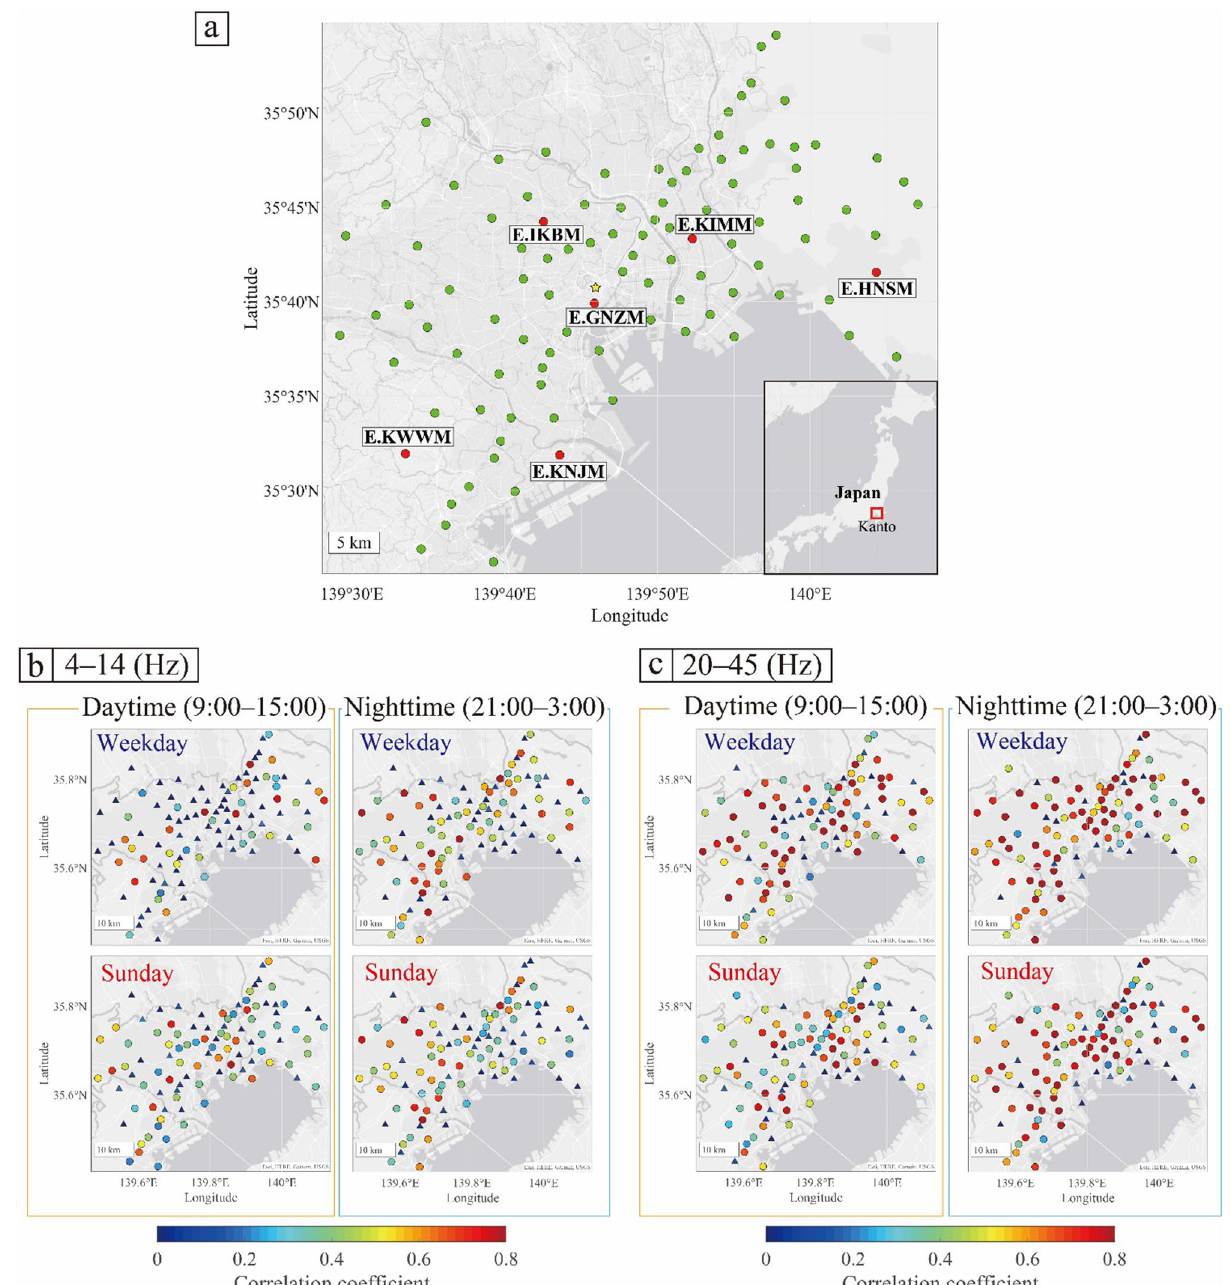
Figure 2. ( a ) Arrangement of the MeSO-net. Red and green dots show the MeSO-net stations. The yellow star indicates the Tokyo station. ( b , c ) Map of correlation coefficients, which were calculated considering day and time in the frequency range of ( b ) 4–14 Hz and ( c ) 20–45 Hz. Triangles represent the stations that showed correlation coefficients < 0.2 and circles represent the stations with correlation coefficients > 0.2; the latter were used in Figs. 6, 7, and